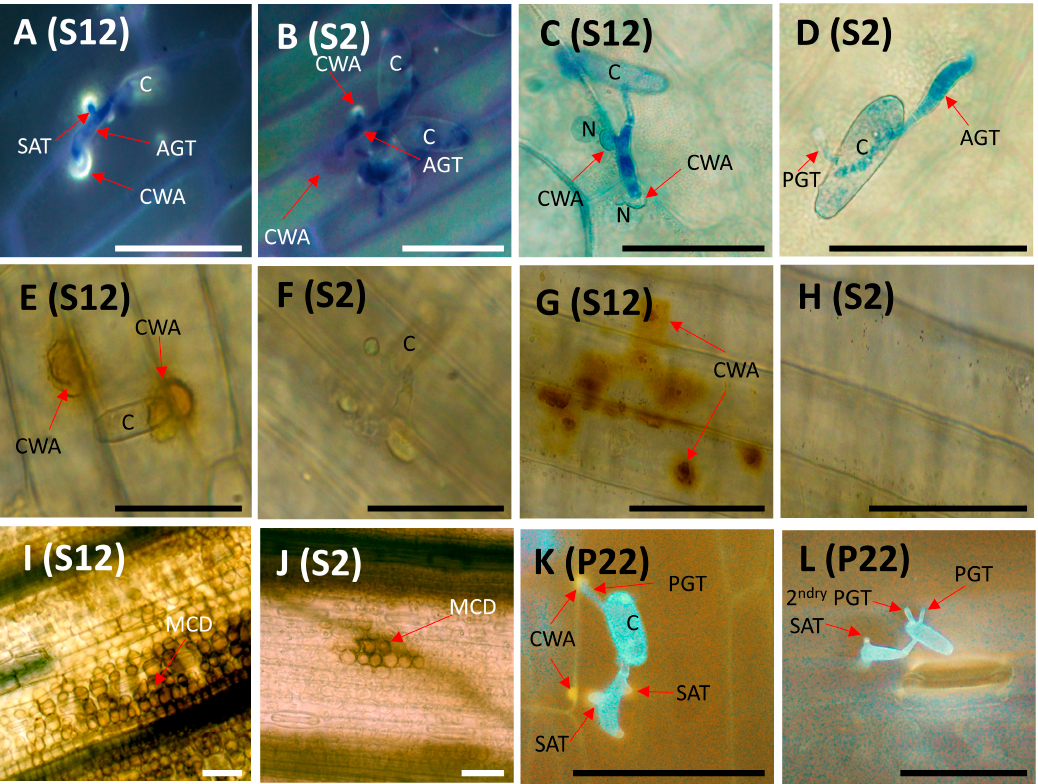
Figure 3. Microscopic images of Baudin near-isogenic line (NIL) responses to attempted penetration by Blumeria graminis f sp. hordei . ( A , C , E , G , I ) are S12 ( mlo-11 ). ( B , D , F , H , J ) are S2 ( mlo-11 ( cnv2 )). ( K ) and ( L ) are NIL P22 ( mlo-5 ). ( G – J ) were not inoculated. ( A , B ) were double-stained with aniline blue and Evans blue for visualizing cell-wall appositions (CWAs). ( C , D ) were stained with trypan blue. ( E – J ) were stained with 3,3 ′ -diaminobenzidine (DAB). ( K , L ) were triple-stained with aniline blue, calcofluor white, and Evans blue and show Bgh phenotypic responses in P22. Abbreviations: AGT, appressorial germ tube; C, conidia; CWA, cell-wall apposition; MCD, mesophyll cell death; N, nucleus; PGT, primary germ tube; SAT, secondary appressorial tube. Scale bar represents 50 µm.